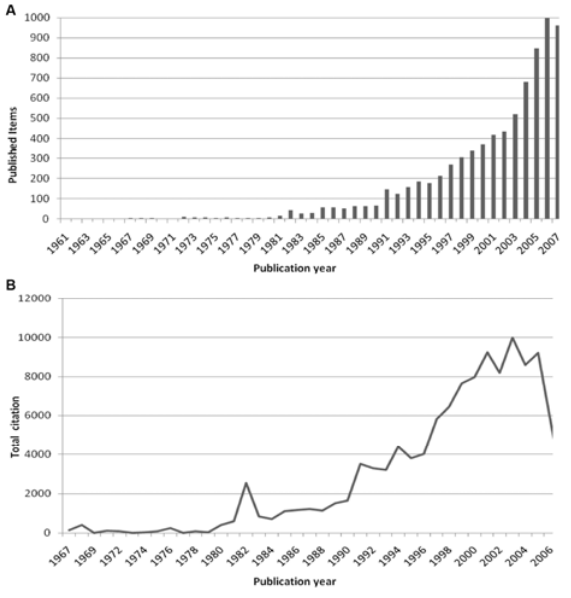
Figure 1. Number of publications and citations ( A ) Analysis of total number of published items. ( B ) Analysis of total number of citations of published items per year. From 1990 onwards are abstracts included to the